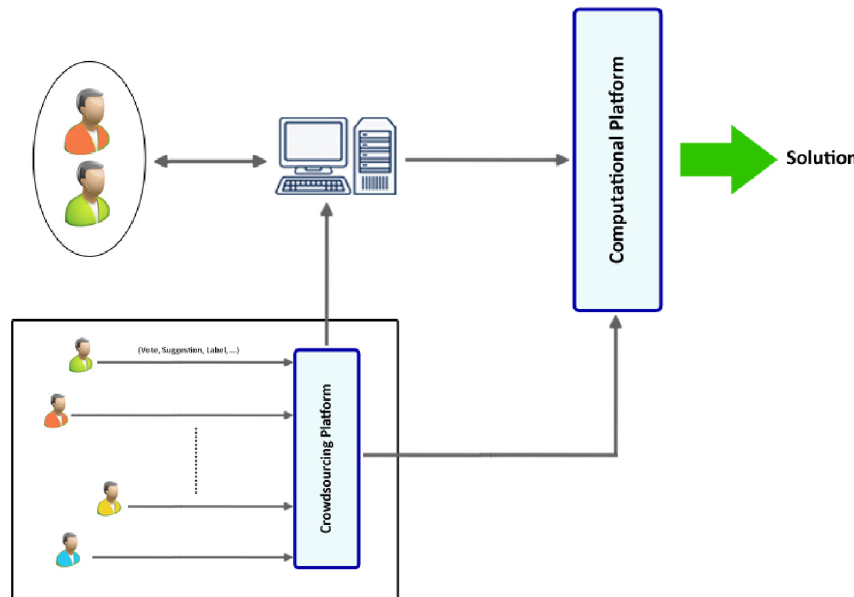
Figure 3. Simpli fi ed schematic of hybrid intelligence work fl